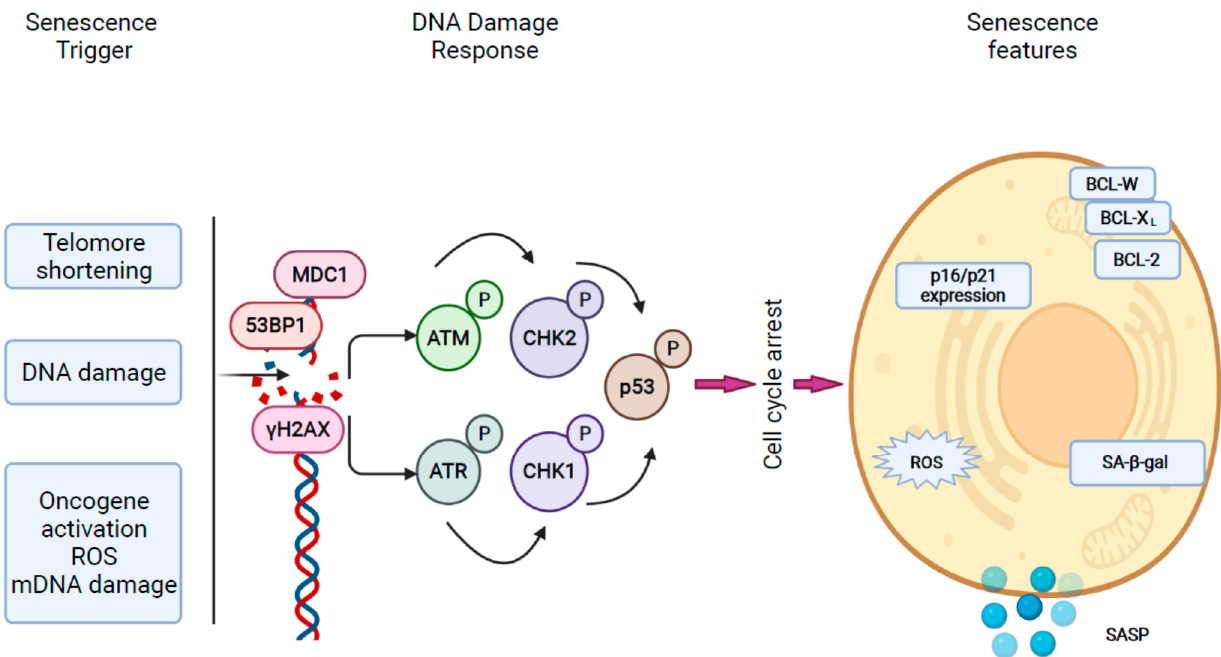
Figure 2. Mechanisms of cellular senescence. Cellular senescence can have various triggers such as telomere shortening, DNA damage, oncogene activation and mitochondria-related factors such as reactive oxygen species (ROS) and mitochondrial DNA damage. Upon injury, the DNA damage response (DDR) mechanisms are activated and signal transduction through protein phosphorylation of ATM, ATR, CHKs stabilizes p53, thus inducing cell cycle arrest through RB. Senescence cells show high expression of p16 and p21 and high activity of SA- β -gal and secrete cytokines and chemoattractants via SASP (modified from Di Micco R et al. [30]).